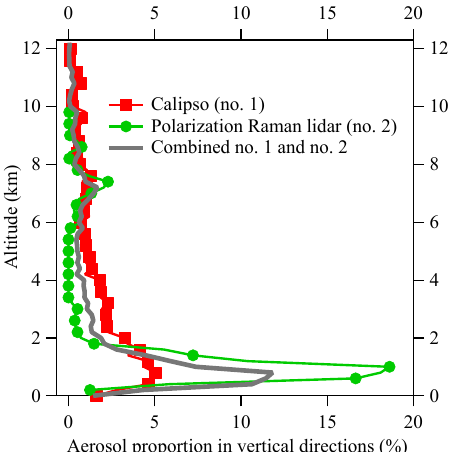
Figure 11. The aerosol vertical proportions (%) from CALIPSO and the polarization Raman lidar and their average in